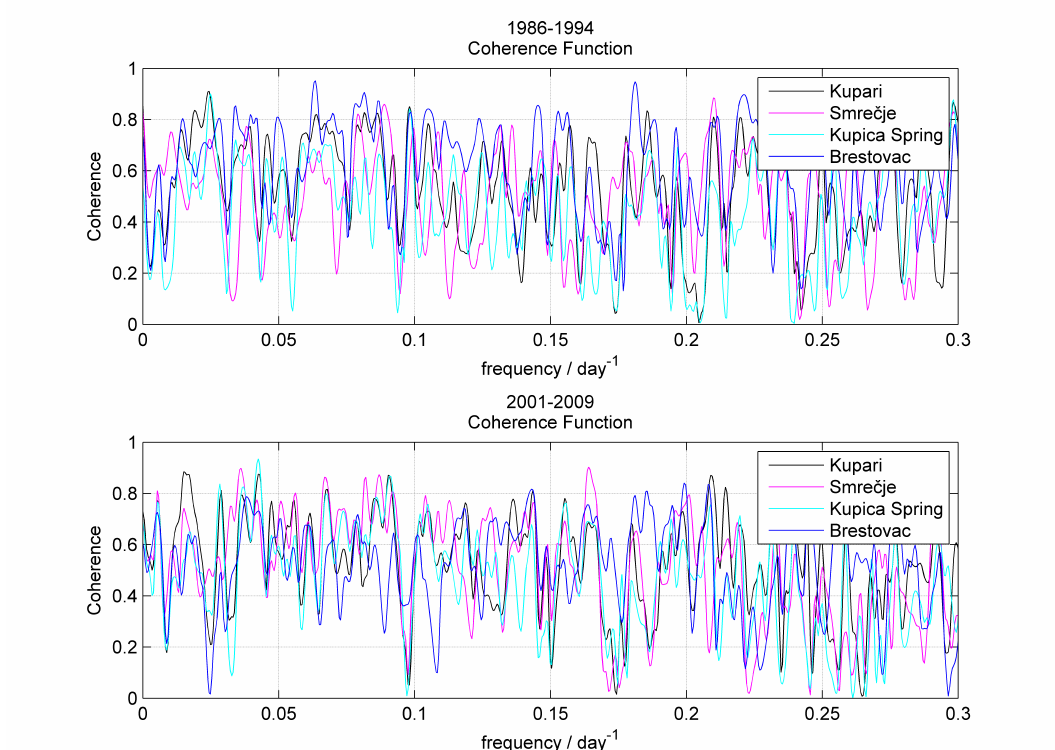
Figure 7. The coherence function obtained for studied hydrological and meteorological stations for the two analyzed